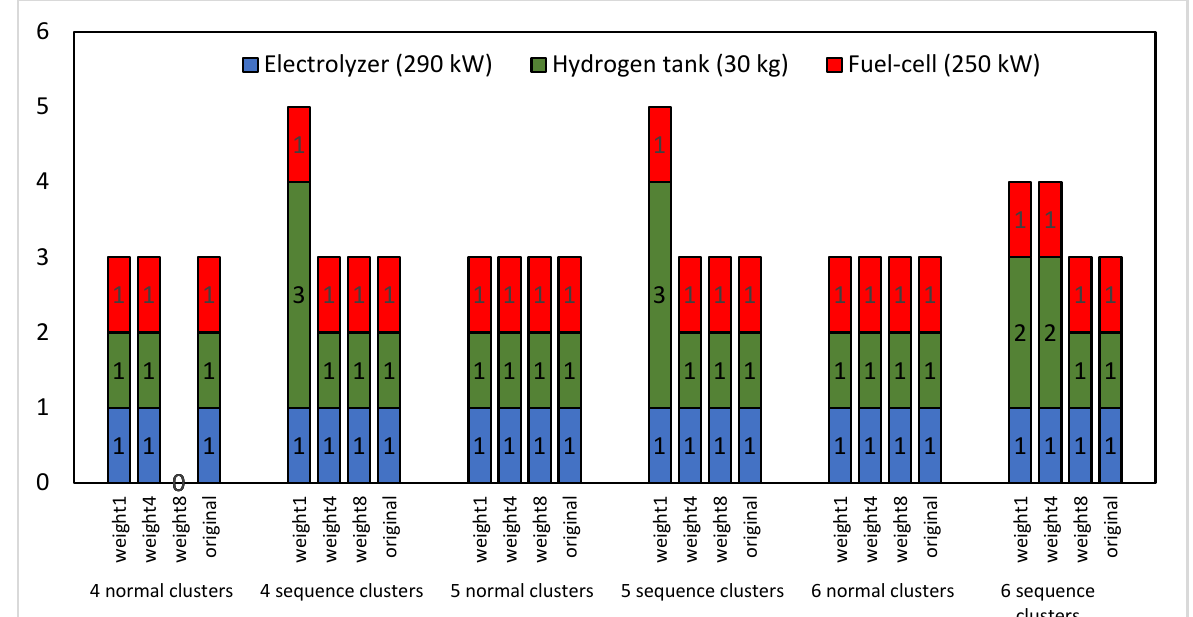
Figure 13. Number of installed storing facilities suggested by the original and clustered models under the GHG emissions constraint.